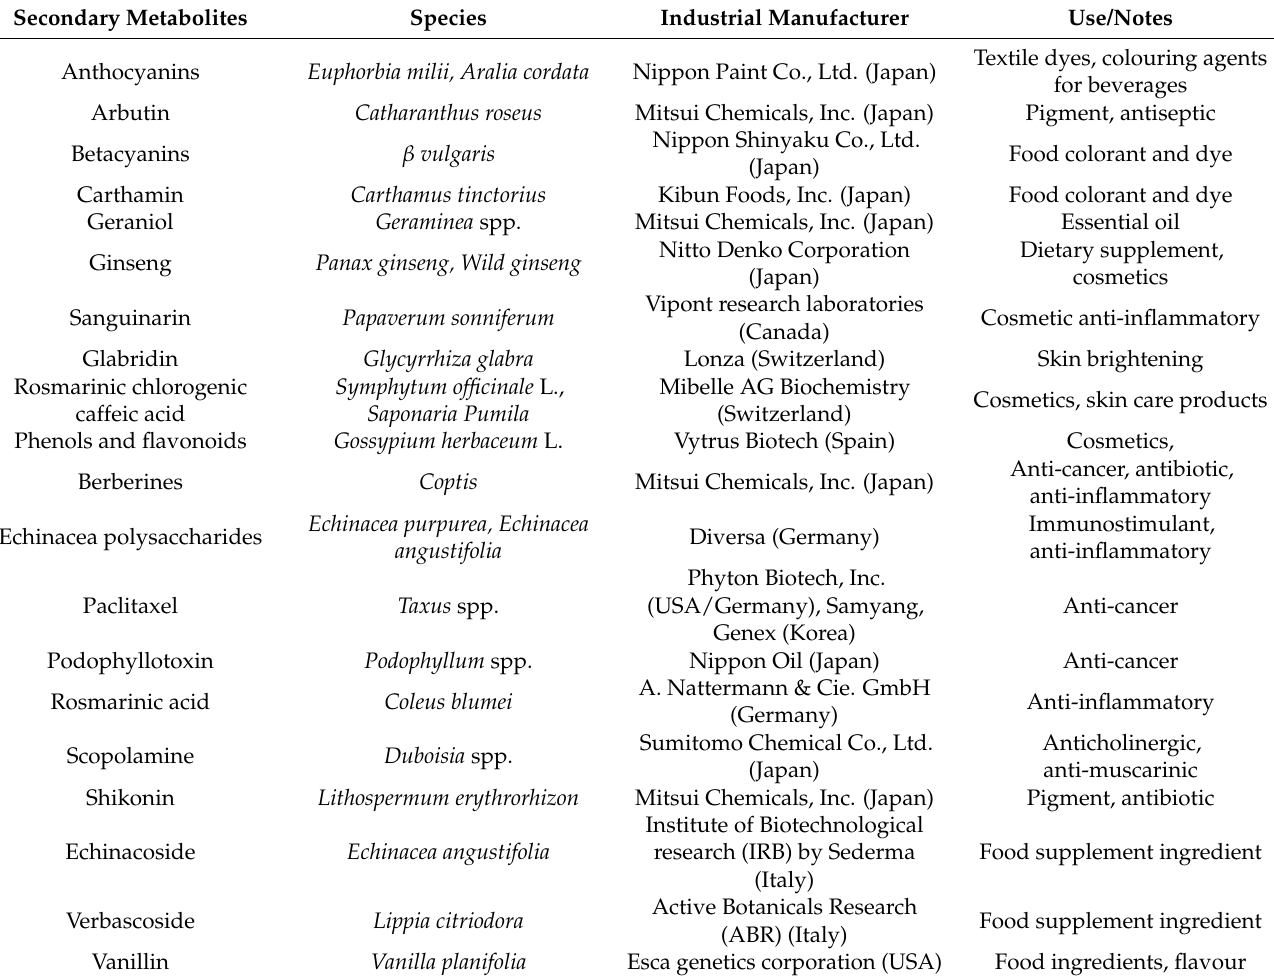
Table 2. Commercial production of plant-derived compounds via plant cell culture modified from Krasteva et al., 2021, and Wilson et al., 2012 [87,90].